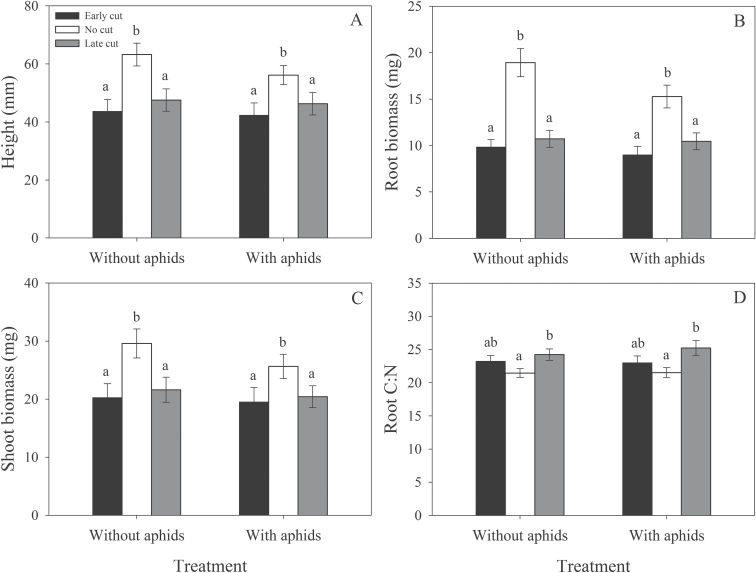
Effects of plant-damage treatment on plant height (A), root biomass (B), shoot biomass (C), and root C:N (D). Mean values (± SE) are shown. Bars with the same letters were not significantly different (P<0.05).